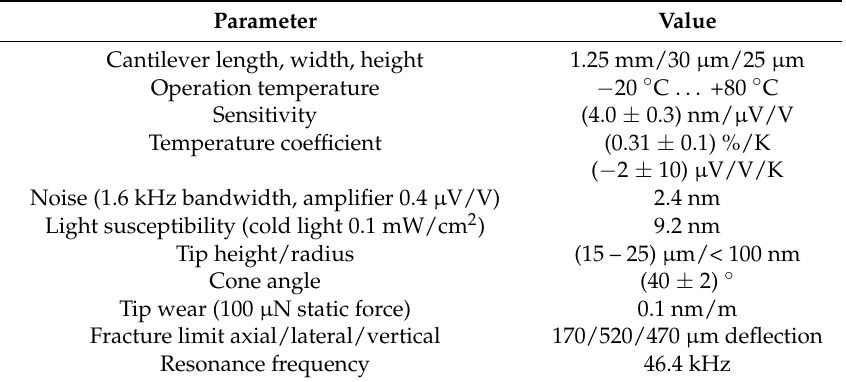
Table 4. Specifications of the 1.25-mm in length piezo-resistive silicon